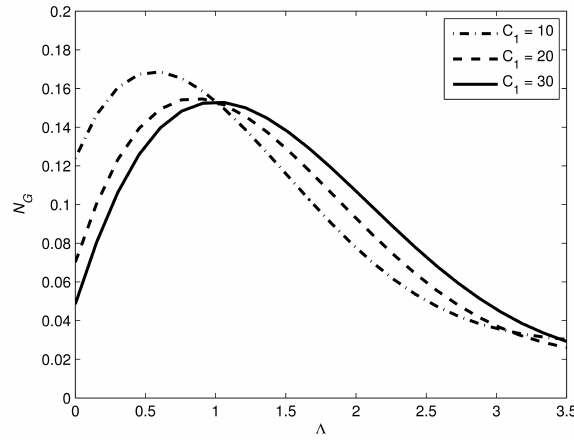
Figure 25: Effect of C 1 on N G keeping ζ = η = 0.2 , C 2 = C 3 = 10 ,